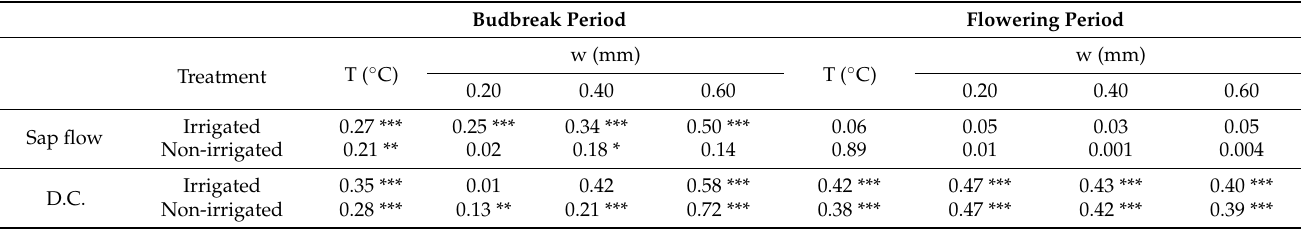
Table 2. Pearson correlation coefficient between sap flow, air temperature, and soil moisture, and dendrometric changes with air temperature and soil moisture in the irrigated and non-irrigated